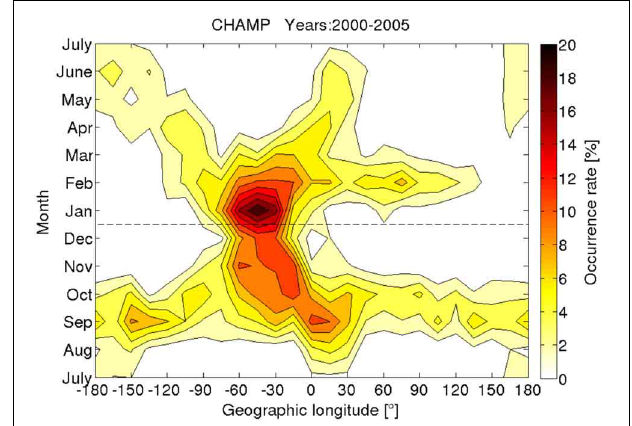
FIGURE 2 | The seasonal/longitudinal distribution of intermediate-scale plasma structure occurrence rates.